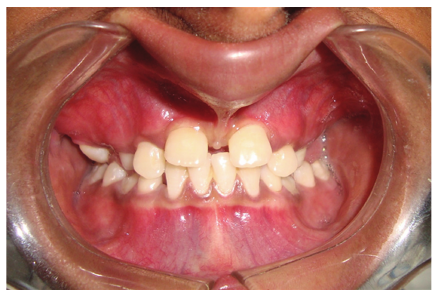
Figure 4: Intraoral photograph showing mandibular arch (Case 1).